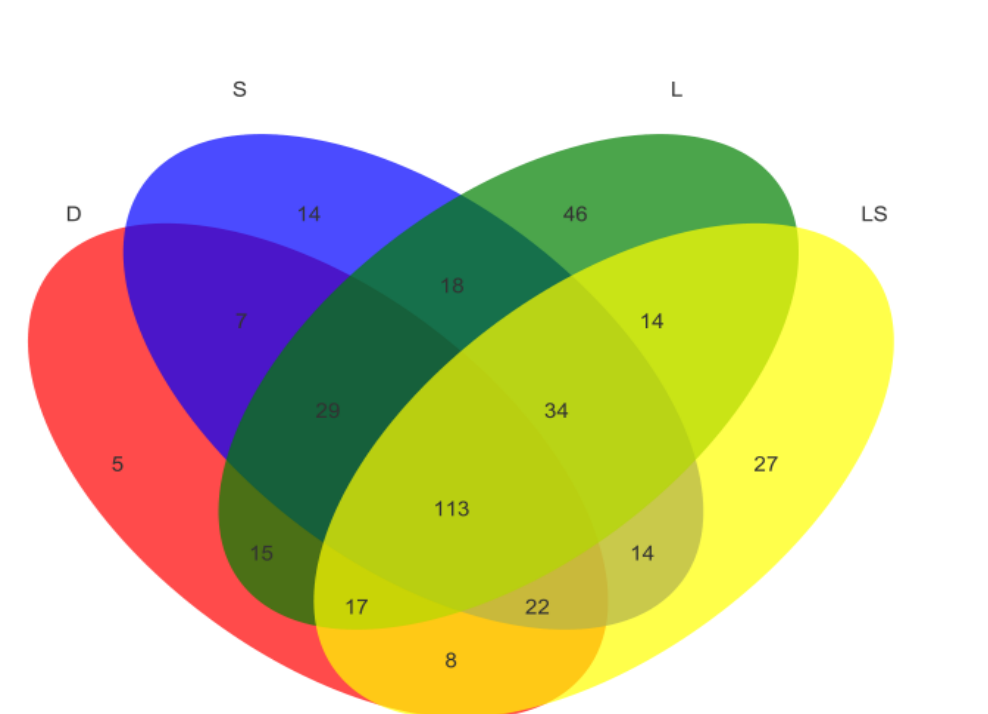
Figure 4. A Venn diagram based on the operational taxonomic units of newborn calves in the different probiotic treatment groups.